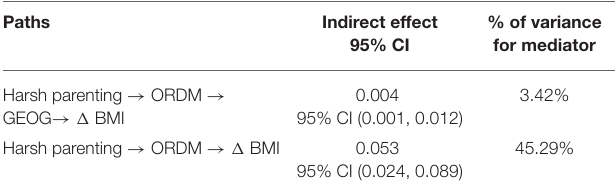
TABLE 3 | Summary of indirect effects.